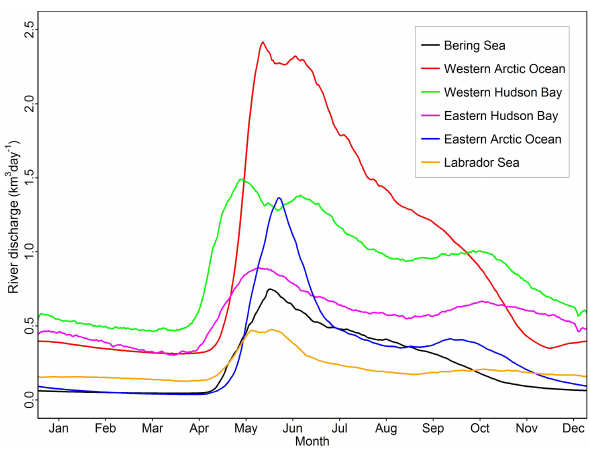
Figure 9. Climatological hydrographs of daily mean river discharge for six major drainage basins of northern Canada,